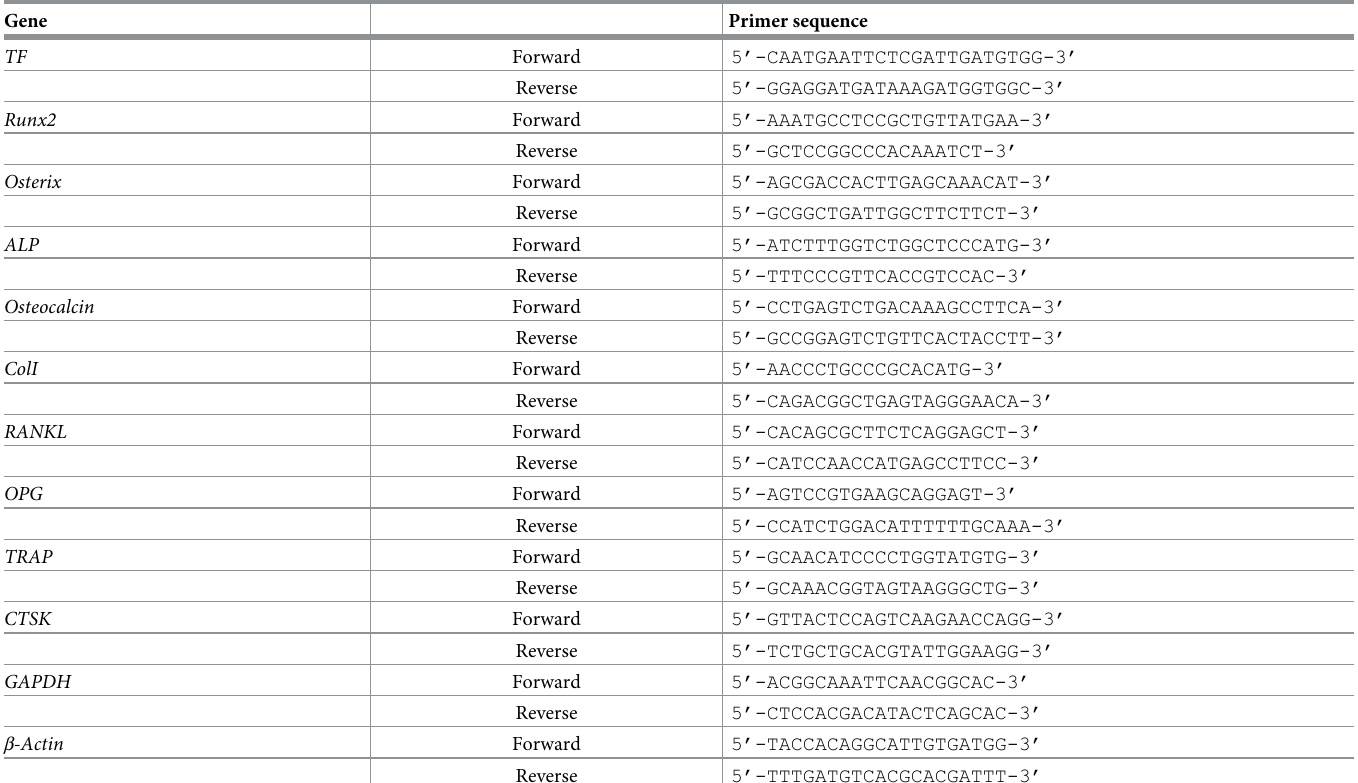
Table 1. Primers used for real-time PCR experiments.